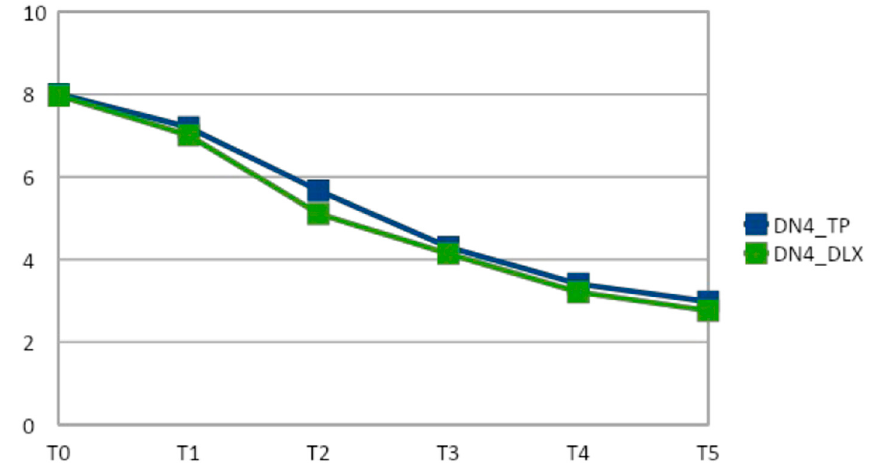
Figure 3. DN4 in TP and TP plus DLX groups (x: DN4, y: time points).